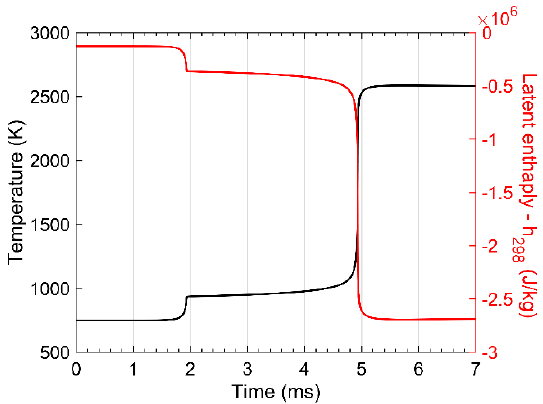
Figure 3. Temperature (black) and latent enthalpy at 298 K (red) as function of time for a constant pressure reactor calculation at 10 bar and 750 K for stochiometric n -heptane/air mixture.